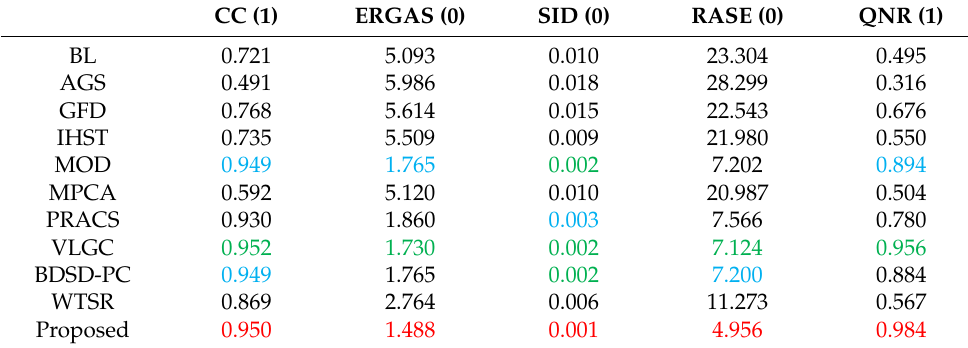
Table 2. The second group of quantitative results.